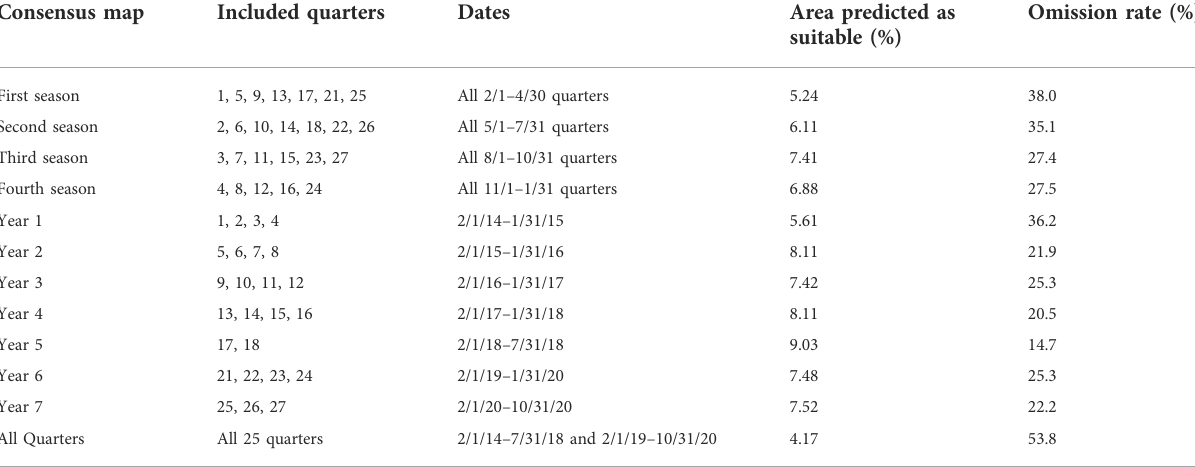
TABLE 2 Consensus map aggregations with descriptive statistics and results. This table shows the consensus aggregation with the quarters used for each, the dates for each consensus map, the percentage of area predicted as suitable after converting to a binary map, and the omission rate of the binary